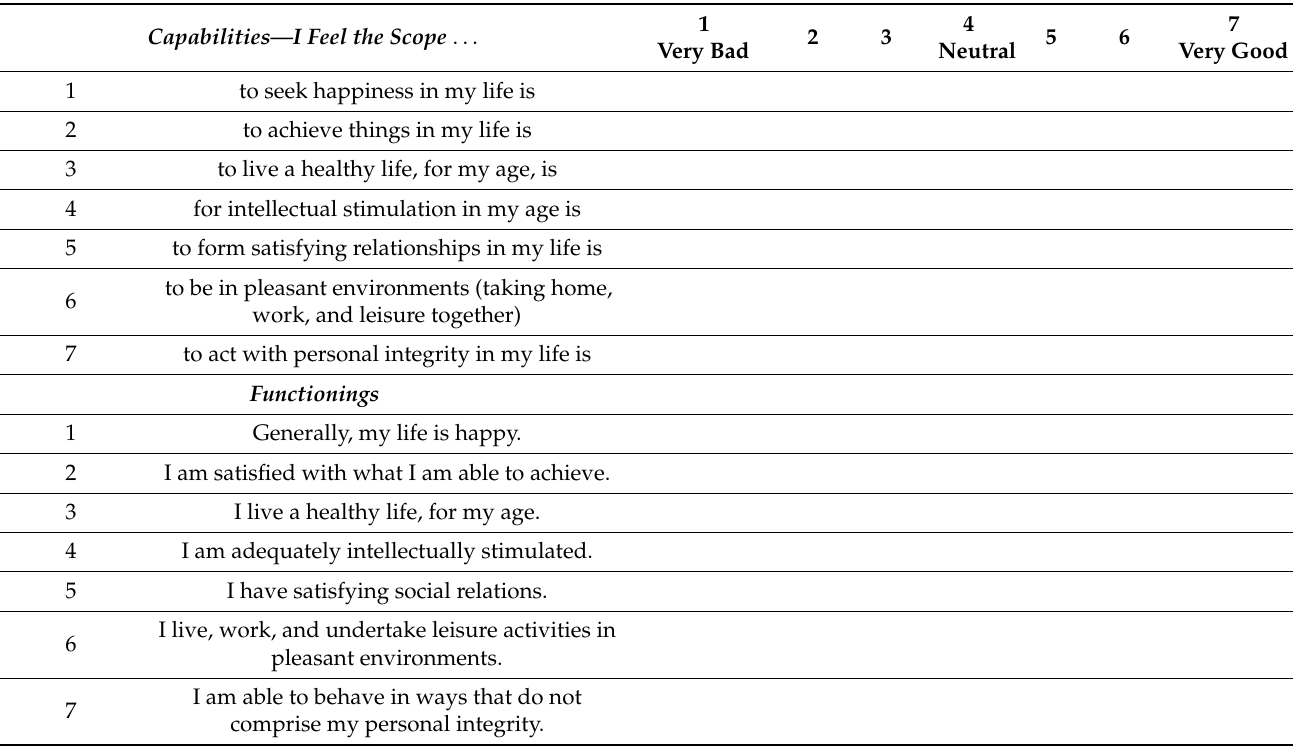
Table 2. Capability and functioning